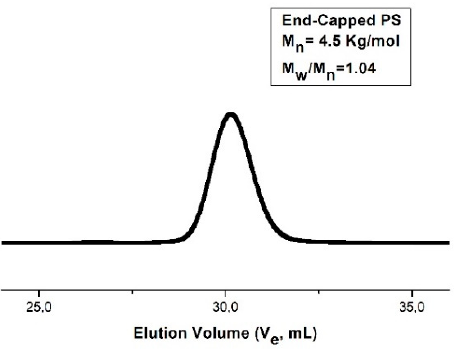
Figure 1. Size exclusion chromatography eluogram of DPE-CB end-capped PS 4.5 Kg/mol.